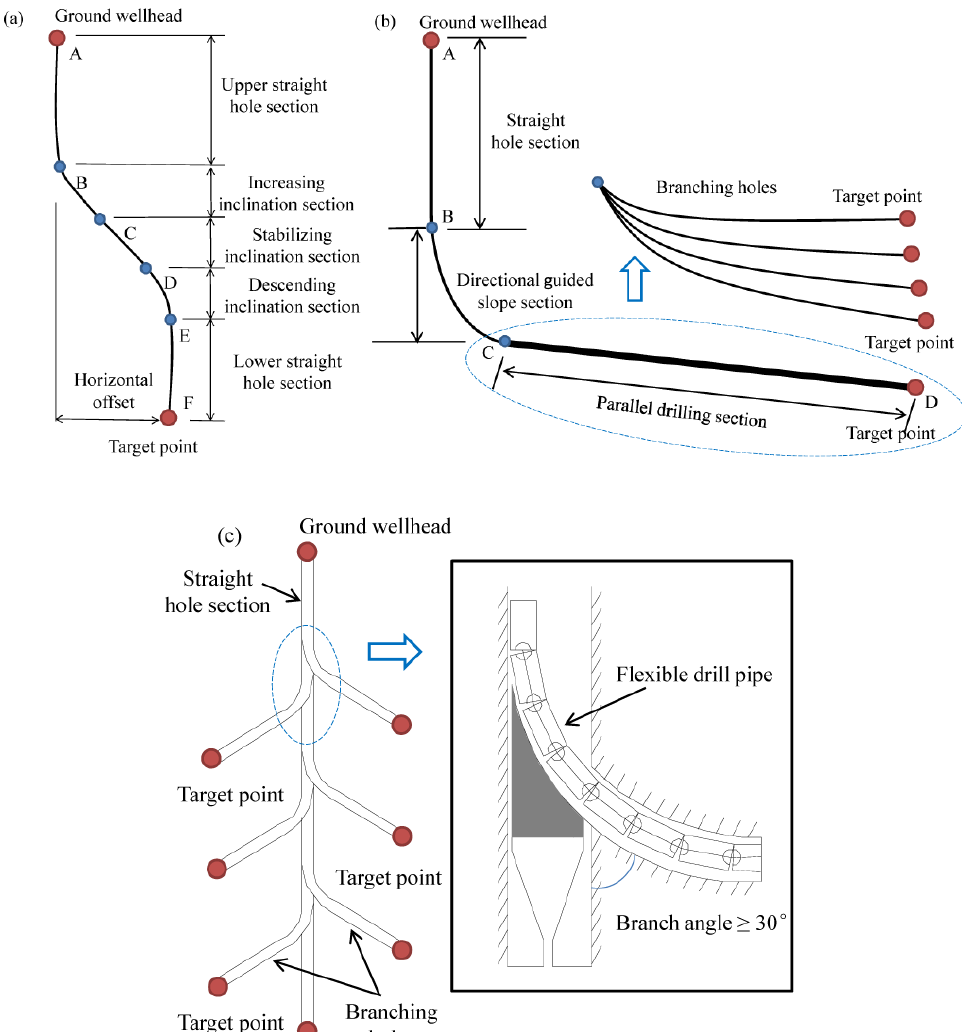
Figure 4. Directional drillings used in mine curtain grouting projects: ( a ) S-shaped directional drilling; ( b ) L-shaped directional drilling; ( c ) fishbone-shaped directional drilling.